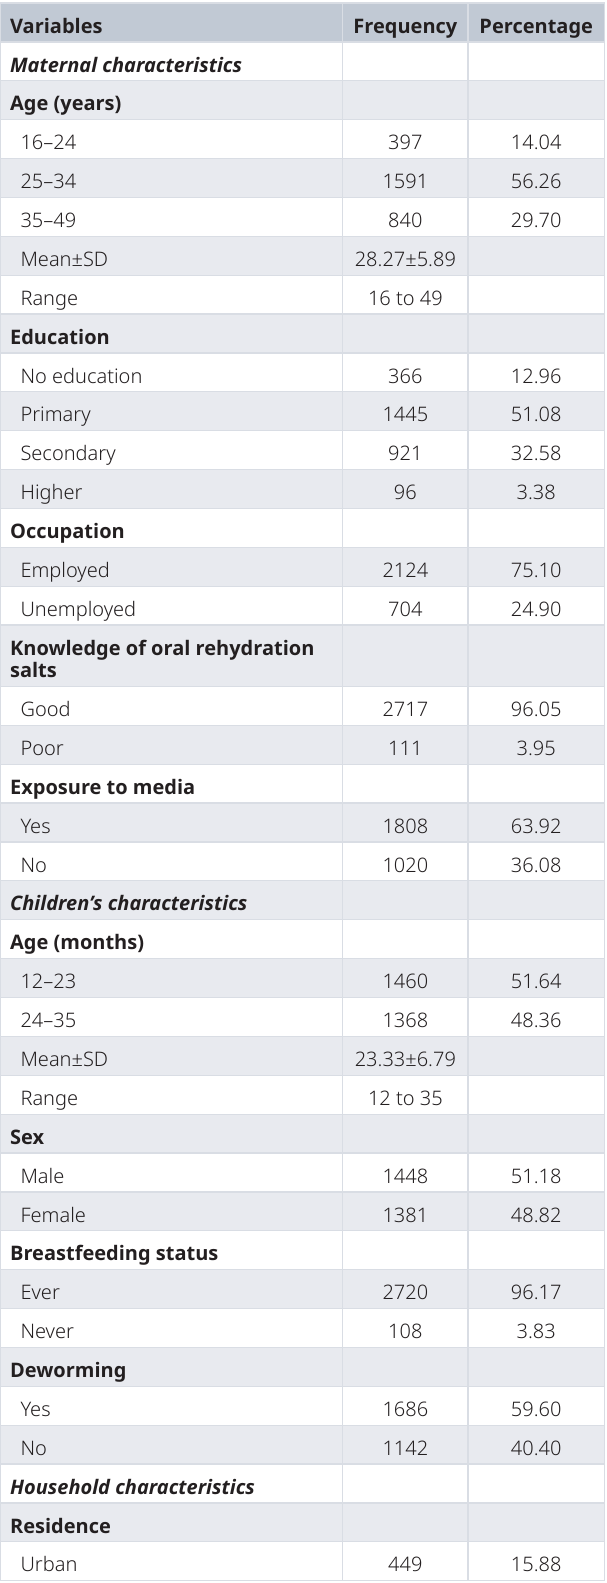
Table 3. Socio-demographic and environmental characteristics of households in Cambodia, 2014